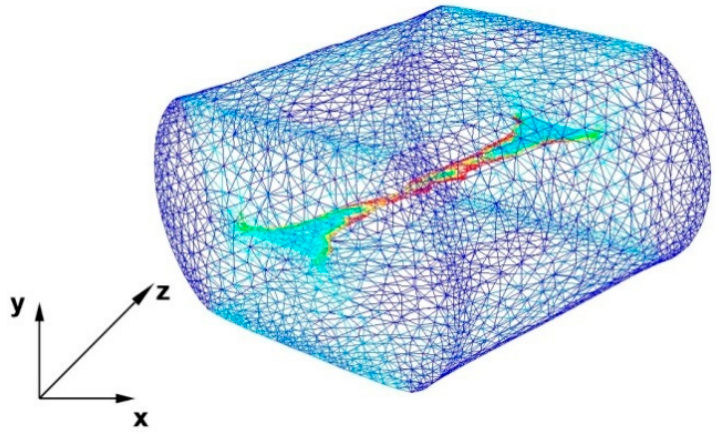
Figure 9. View of an unheated fully modeled discontinuity intended to simulate the central porosity inside a circular sample deformed with 35% reduction.